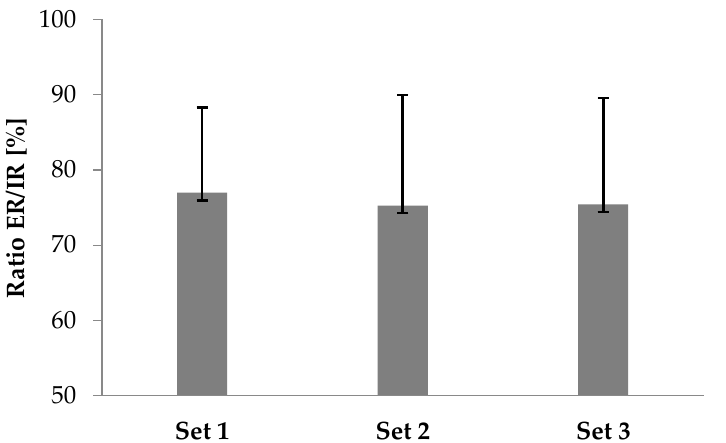
Figure 2. Ratio of external (ER) and internal (IR) rotation (ER/IR ratio) during the isokinetic fatigue protocol.